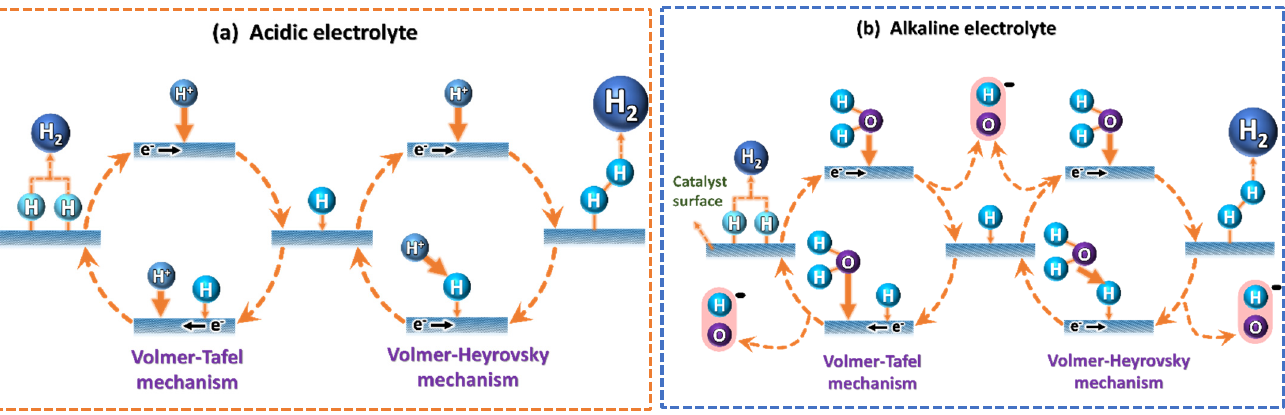
Figure 2. Schematic illustration of the hydrogen evolution reaction mechanism in ( a ) acidic and ( b ) alkaline media. HER. Table 1. HER reactions in acidic and alkaline electrolytes and their respective Tafel slopes.